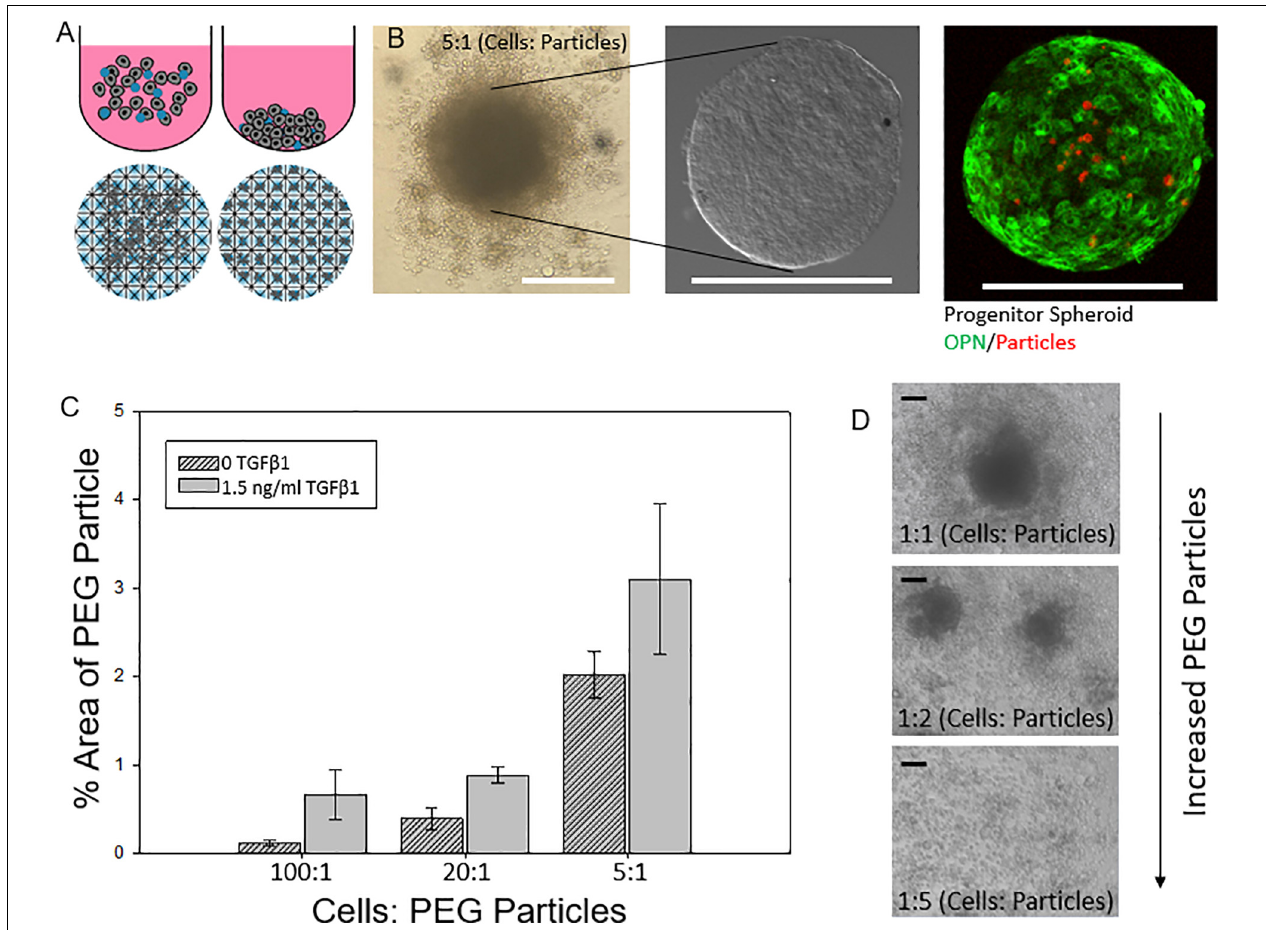
FIGURE 3 | Engineering liver differentiation through hydrogel microparticles. (A) Spheroids made by one of two methods. (Top) Cells added to the wells of an Ultra Low Attachment (ULA) plate and allowed to settle and self-organize. (Bottom) Cells added to the wells of an AggreWell 400 plate (STEMCELL Tech, Cat.# 34421) and centrifuged to form spheroids in the microwells. Scale bars: 200 µ m (B) ULA spheroids with PEG particles during formation- many of the PEG particles are not incorporated into the fully formed spheroid, after being removed from the well, cleaned and fixed, and after staining for differentiation markers. (C) Percent area of a confocal image z slice that is occupied by a PEG particle vs a cell for increasing concentrations of initial added particles with and without TGF β 1. (D) Integration of PEG particle into the spheroid based on initial ratio of cells: particles for spheroids with and without soluble TGF β 1. (D) As the relative amount of particles increases past a 2:1 cell: particle ratio, the spheroids become smaller as less cells form the initial aggregate and past a 5:1 particle to cell ratio spheroids no longer form. Scale bar: 100 µ